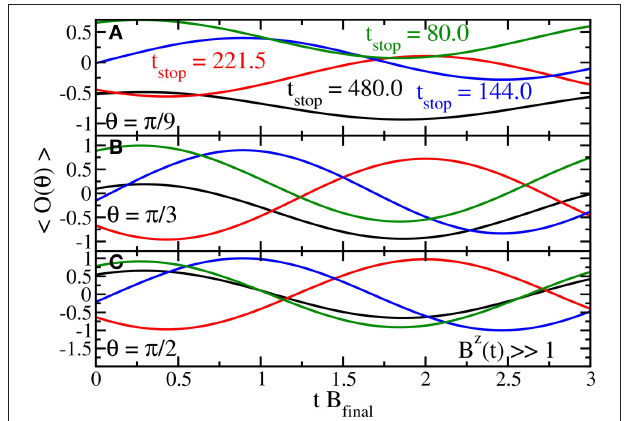
FIGURE 4 | Time evolution of the measurement of ˆ O ( θ ) in the Landau-Zener problem for t stop = 480.0 (black), 221.5 (red), 144.0 (blue), and 80.0 (green) using θ = π/ 6 (A), π/ 3 (B), and π/ 2 (C). The measurement is being done when B z ( t ) ≫ 1 . The amplitude of the oscillations converge to 1 as θ is increased to π/ 2 .